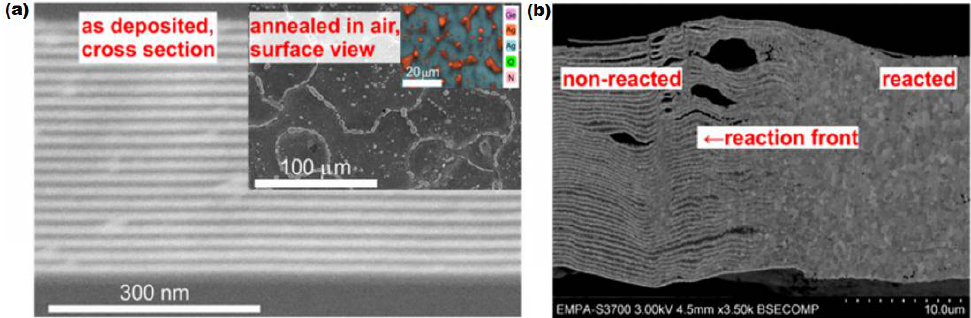
Figure 5. Nanomultilayer filler materials: ( a ) non-reactive Ag/Ge/AlN nanomultilayer for low-temperature joining and ( b ) reactive Ni/Al nanomultilayer as a local heat source for brazing of heat-sensitive materials [106].